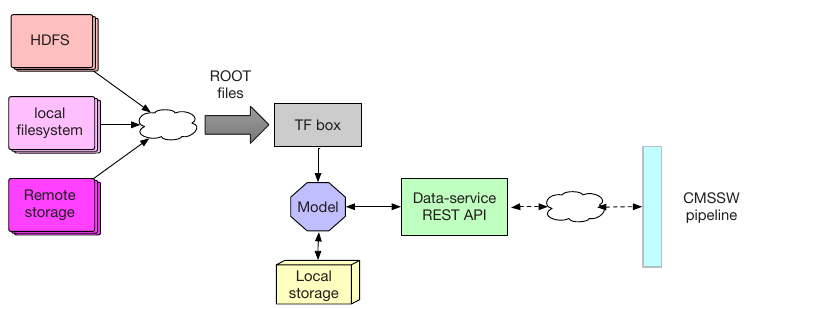
Figure 2. A TensorFlow as a Service [20] architecture for a HEP use case. The input raw data in ROOT data format can be read from remote data-providers, including XRootD servers, local filesystems, and HDFS, be processed and transformed on the HDFS / Spark platform and fed into ML framework for training (e.g. via SparkML). The trained model can be served to end users or the entire framework (CMSSW) as an HTTP based data Figure 1. A typical CMSSpark workflow to process data on HDFS cluster via the Spark framework.